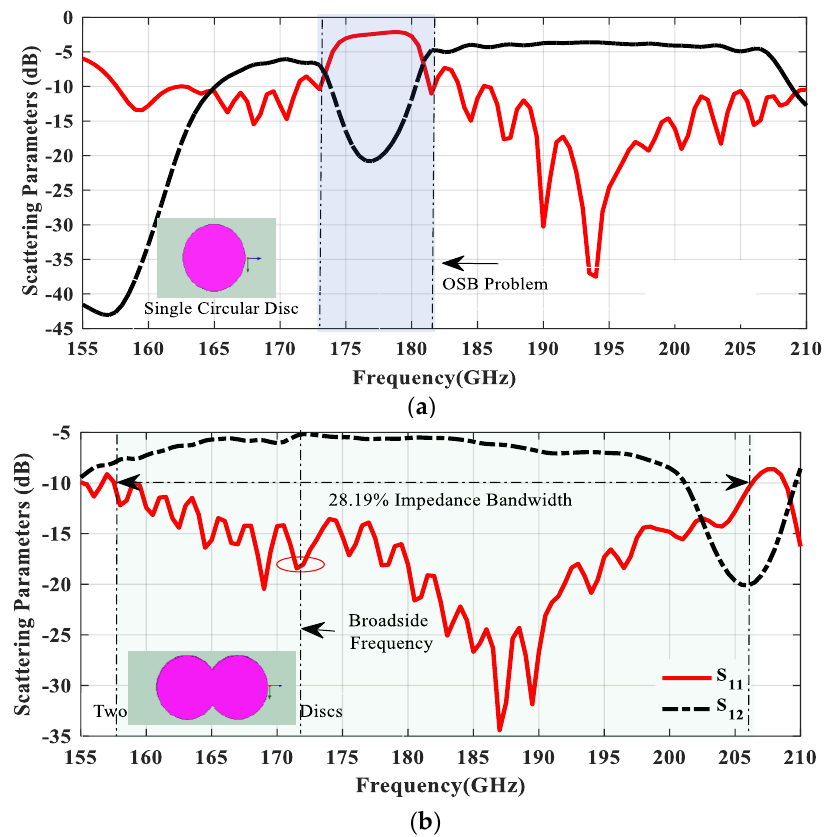
Figure 3. Frequency variation of S-parameters of the proposed antenna for two type of unit-cells; ( a ) one circular disc, ( b ) two overlapped circular discs with a center-to-center spacing of λ g/4.